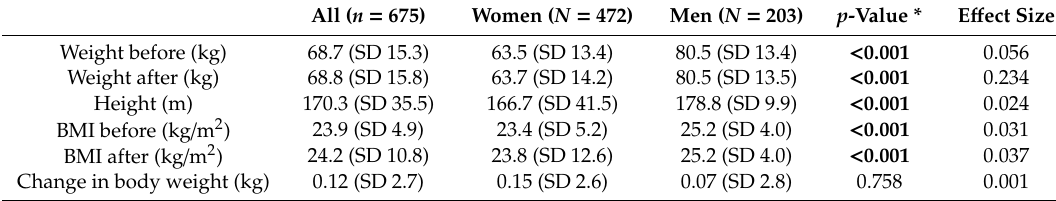
* p -value by Mann-Whitney test. Effect size was computed as η 2 . Bold indicates statistical significance ( p <0.05). BMI during confinement was positively correlated with age (Spearman’s Rs = 0.32, p < 0.01) and this association also remained significant after adjustment for sex, education exercise and sleep.